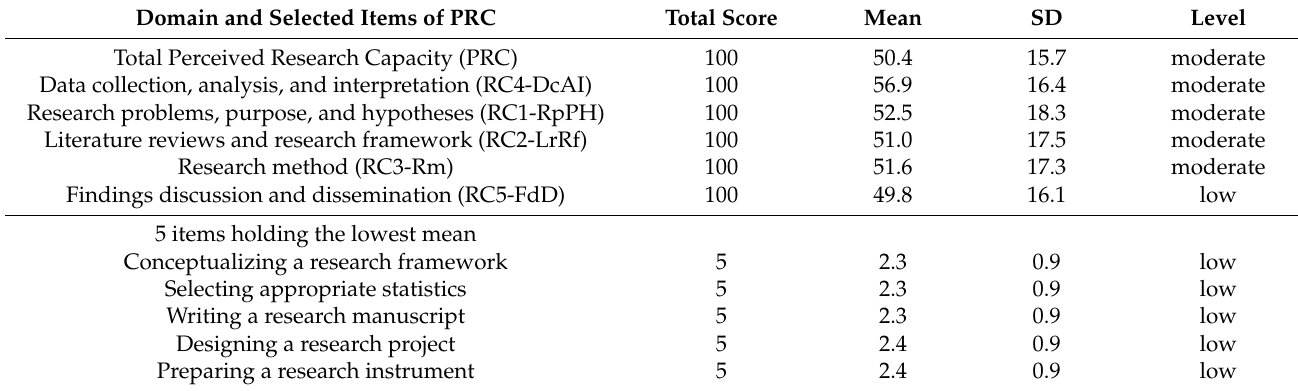
Table 8. Perceived Research Capacity (PRC) ( n = 24).